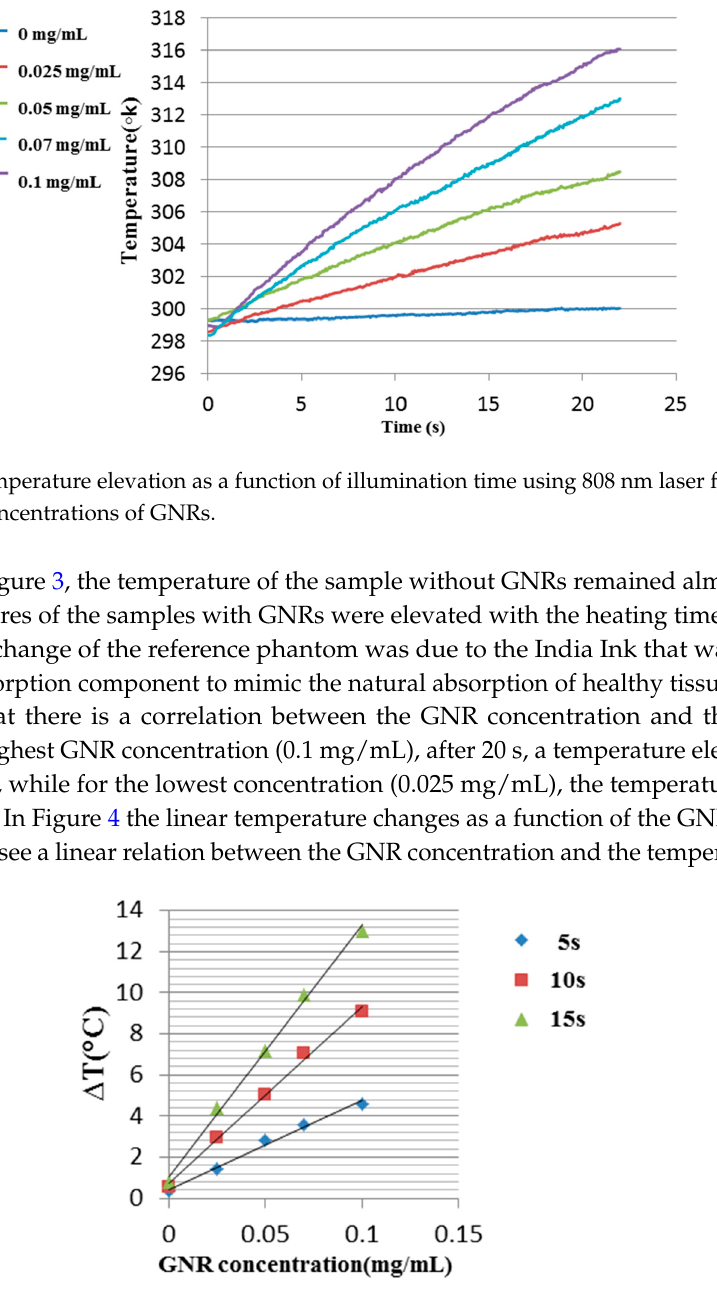
Figure 4. Temperature change as a function of GNRs concentration for three different illuminations times: 5, 10 and 15 s. times: 5, 10 and 15